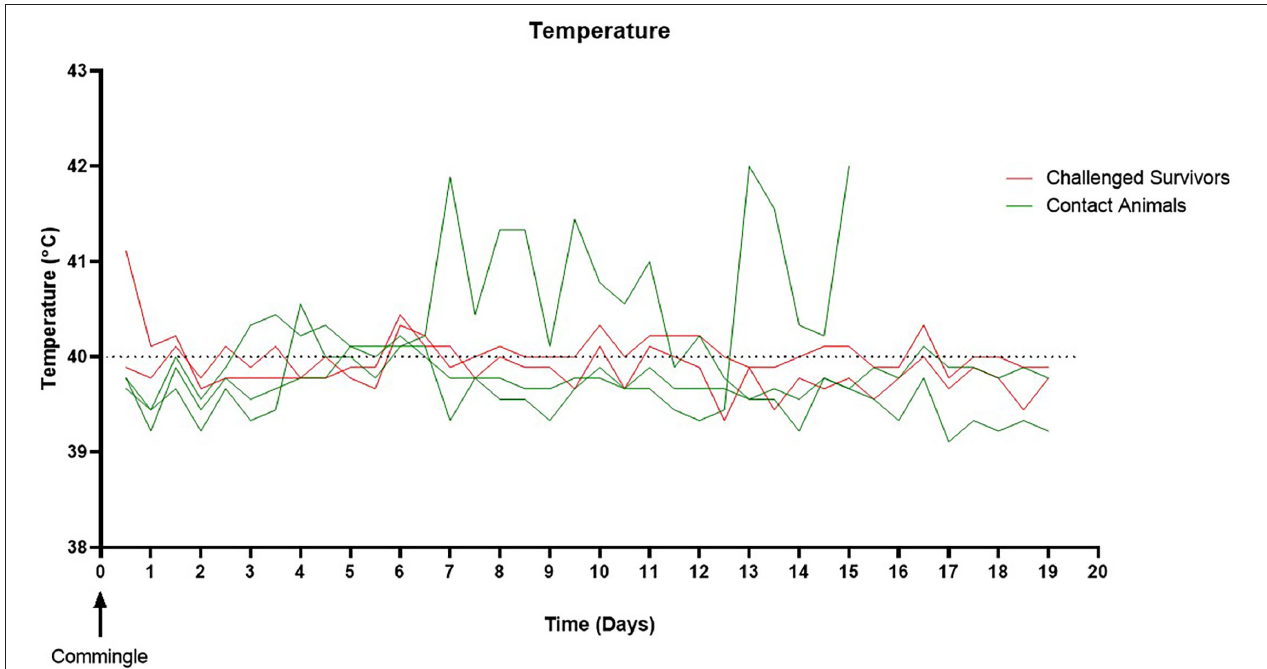
FIGURE 3 | Pig temperature following commingling. All naïve contacts were febrile at one or more time points post-commingling. Two pigs were febrile for multiple readings. One pig developed a fever on day six post-commingling, which remained elevated for 4 days then returned to normal. One pig became febrile on day 12 post-commingling, developed further clinical signs, and was euthanized 15 days post-commingling. The upper limit for normal pig body temperature is marked by the dashed line (40 ◦ C).